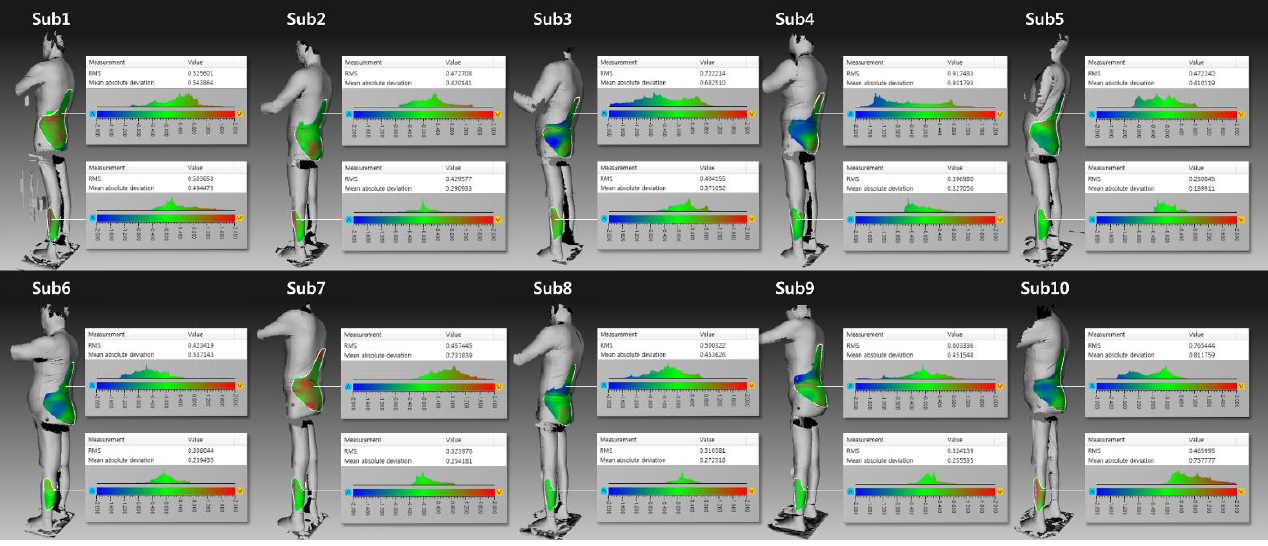
Figure 13. Results of evaluation by shape deviation analysis. Table 12. Results of evaluation by shape deviation analysis (unit: